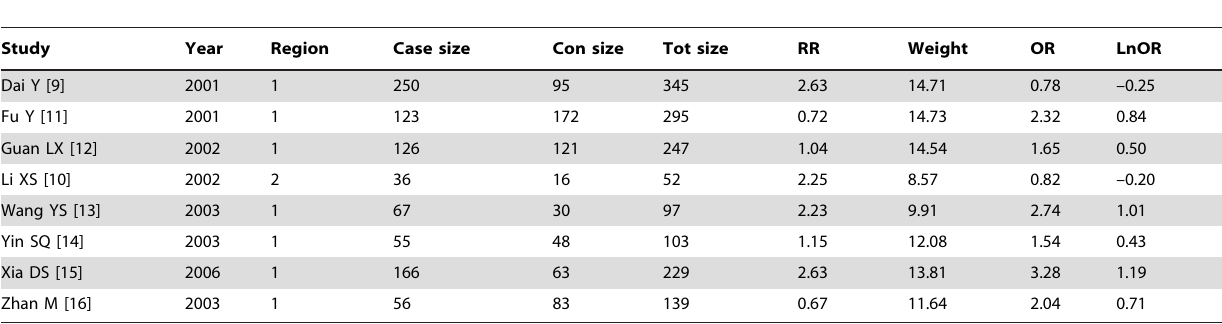
Table 3. The confounding factors for the potential sources of heterogeneity studied by meta-regression.